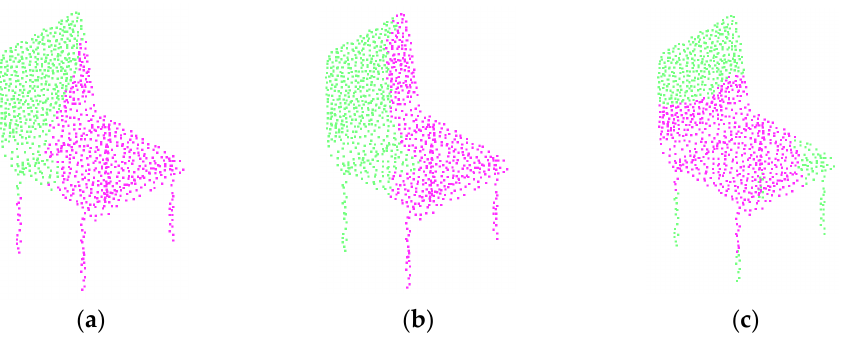
Figure 8. Accuracy of correspondence point estimation: ( a ) TPCC-Net, p = 0.90; ( b ) PRNet, p = 0.51; ( c ) RPM-Net, p = 0.25.